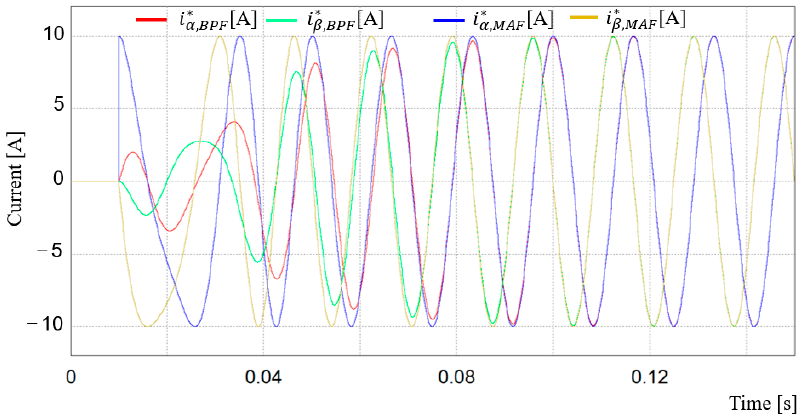
Figure 9. Comparison of the reference current generation in αβ coordinate between the BPF and MAF.